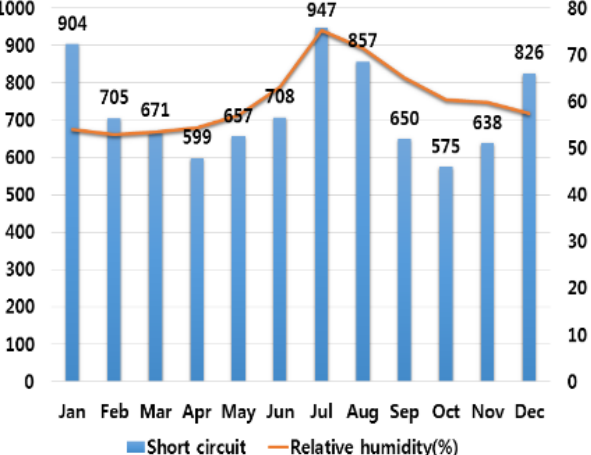
Figure 6. Correlation between the number of fires caused by ground fault and the average humidity on a monthly basis.